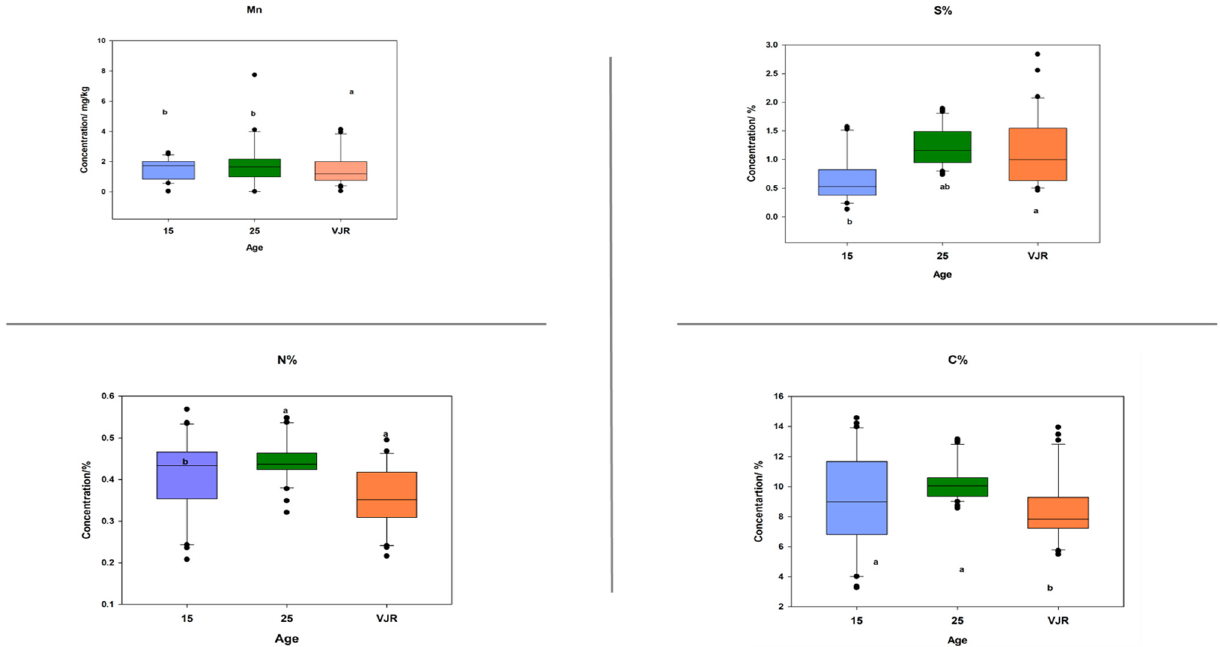
Figure 5. Elemental concentration in roots (the mean was taken for the same age compartments) in boxplot representation with the median, interquartile range, and outliers (black dots). Small letters (a, b, c) show different significance groups where the significance level was set as p < 0.05.